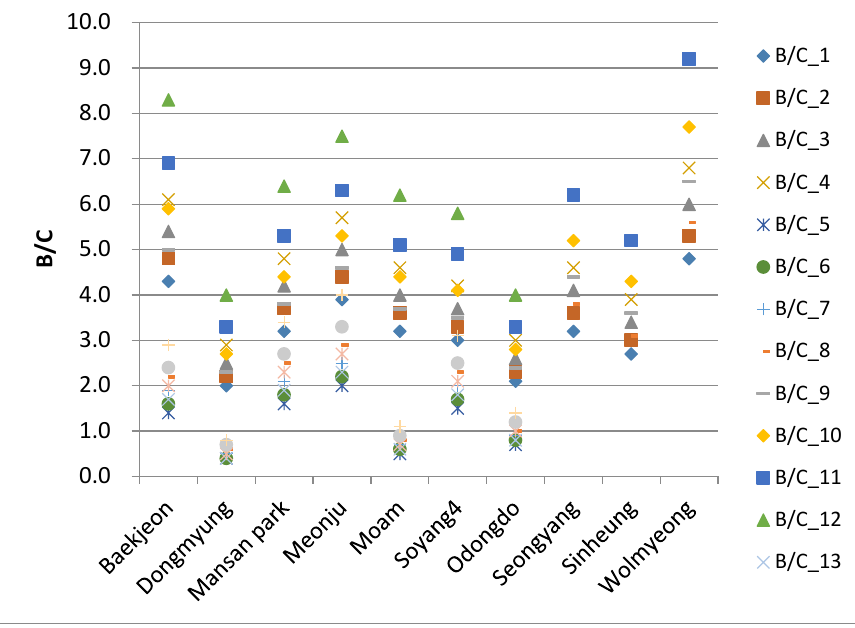
Figure 4. B/C distribution of project sites.